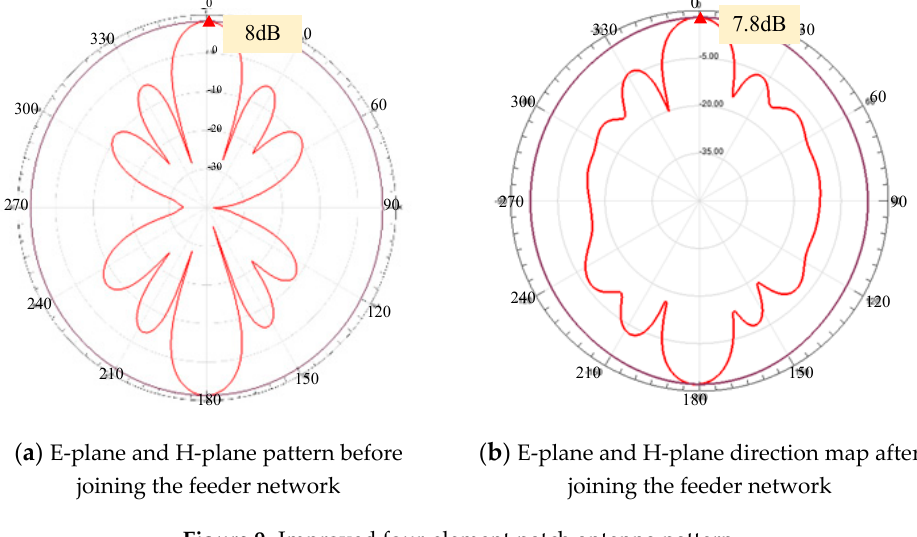
Figure 9. Improved four-element patch antenna pattern.